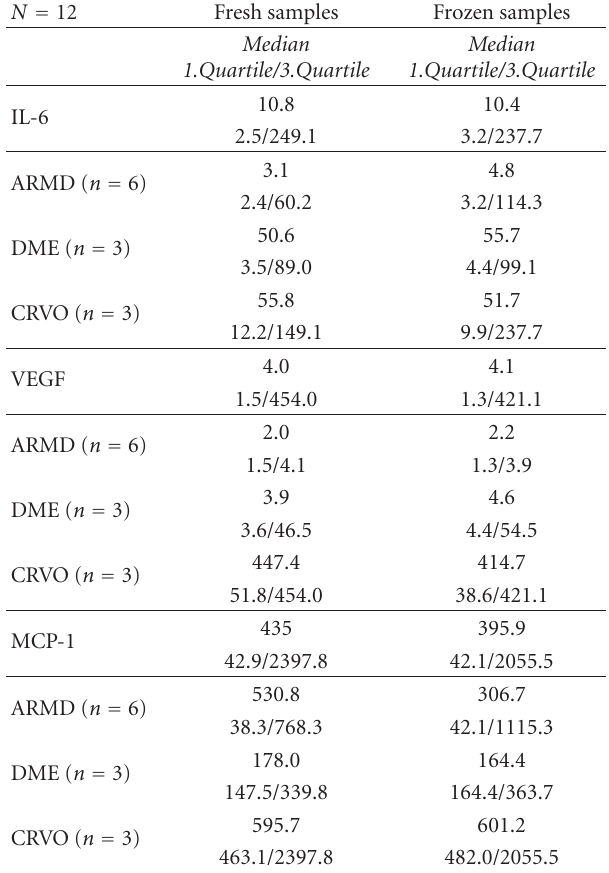
Table 1: Protein values in pg/mL of AMD ( n = 6), DME ( n = 3), and CRVO ( n = 3) patients.